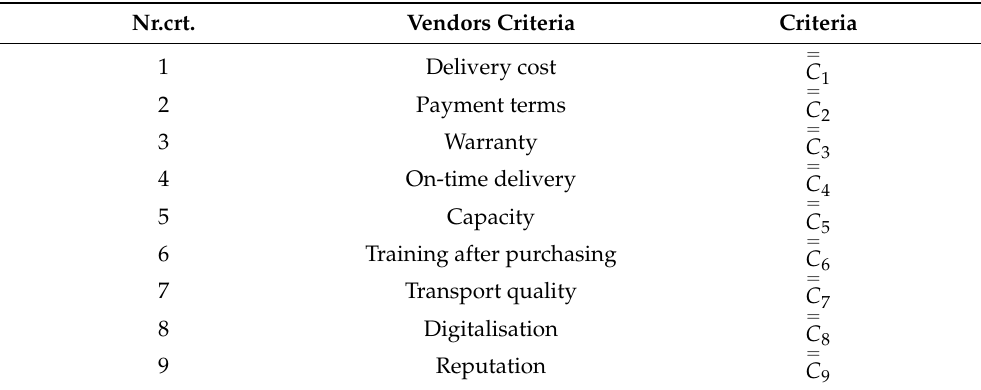
Table 5. The vendor’s criteria and symbols.